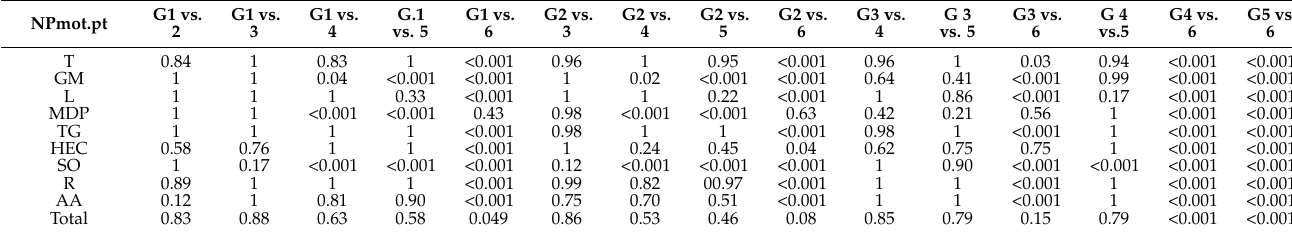
Table 9. Post-hoc Scheffe test scores for the age